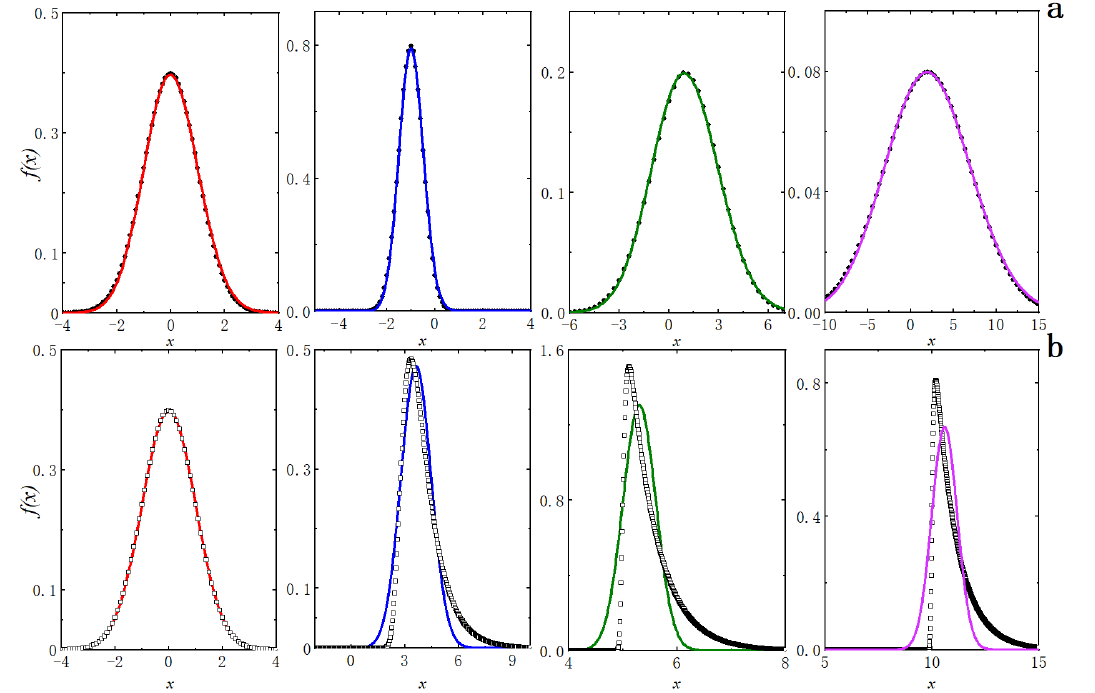
Figure 7. Mutual representation of WJ distributions and Gaussian functions (refer to Table 1 for